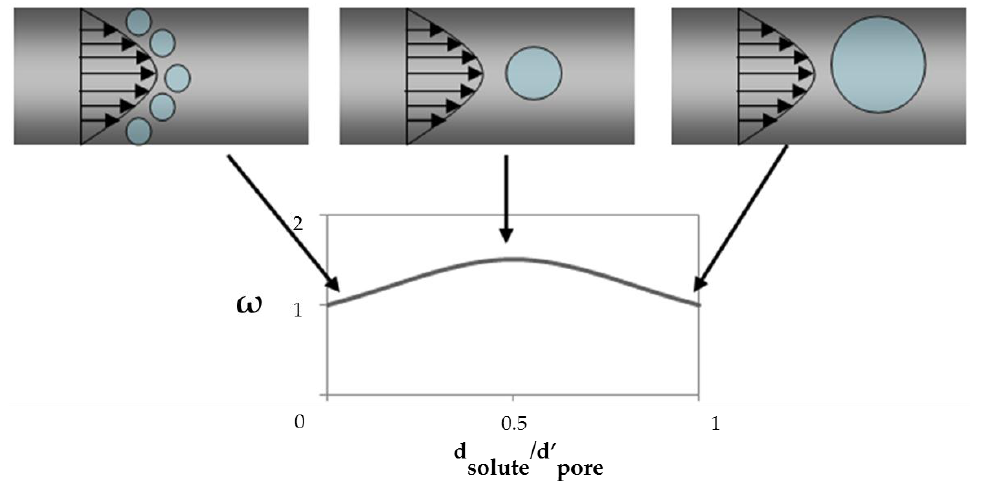
Figure 9. Solute velocity profile through the narrow pores, w is viscous correction factor.